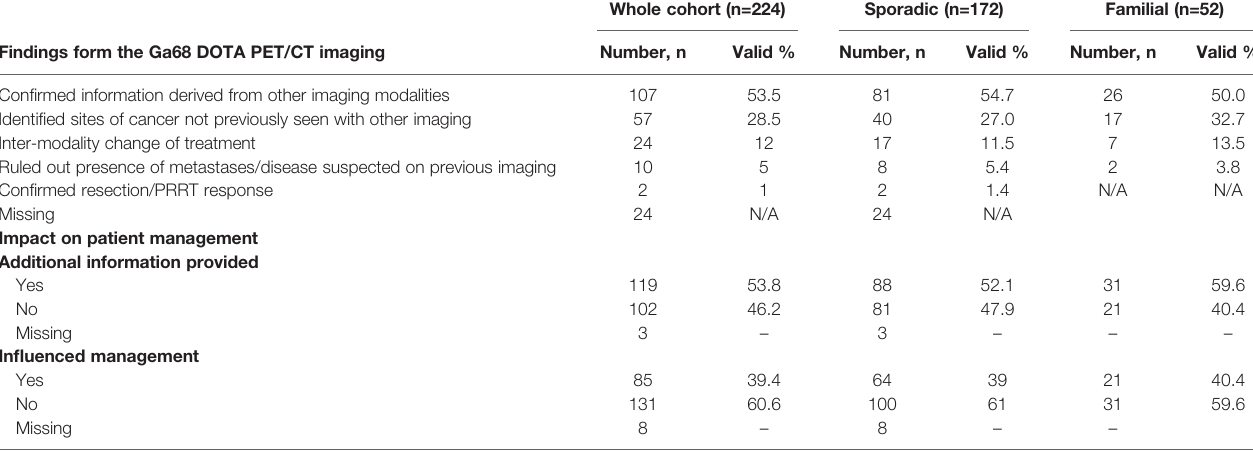
Whole cohort (n=224)